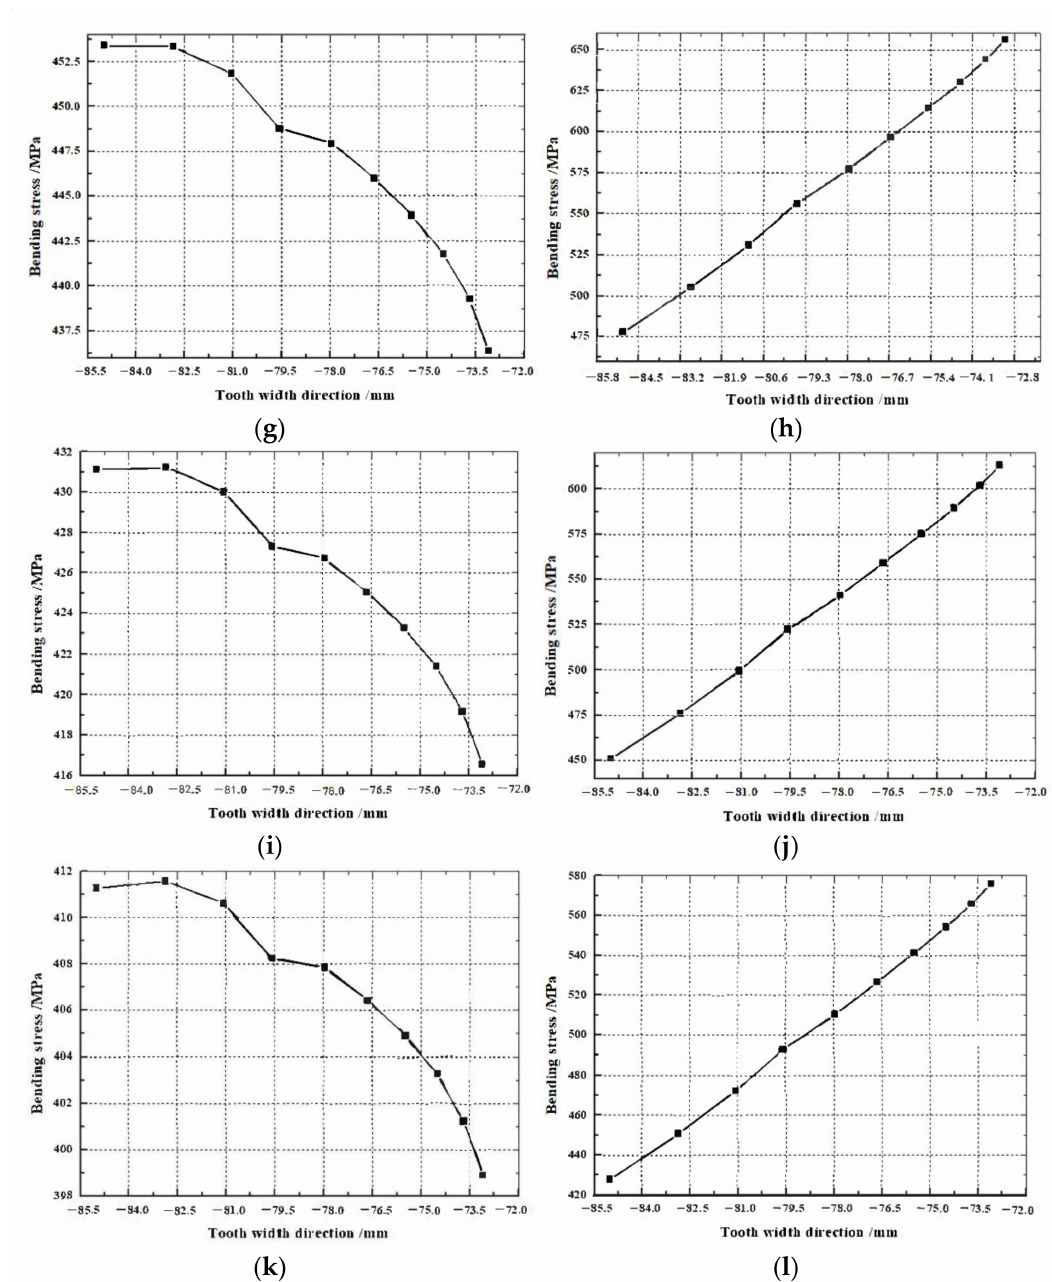
Figure 8. Bending strength of face gear and pinion under different cases: ( a ) face gear bending stress of case 1; ( b ) pinion bending stress of case 1; ( c ) face gear bending stress of case 2; ( d ) pinion bending stress of case 2; ( e ) face gear bending stress of case 3; ( f ) pinion bending stress of case 3; ( g ) face gear bending stress of case 4; ( h ) pinion bending stress of case 4; ( i ) face gear bending stress of case 5; ( j ) pinion bending stress of case 5; ( k ) face gear bending stress of case 6; ( l ) pinion bending stress of case